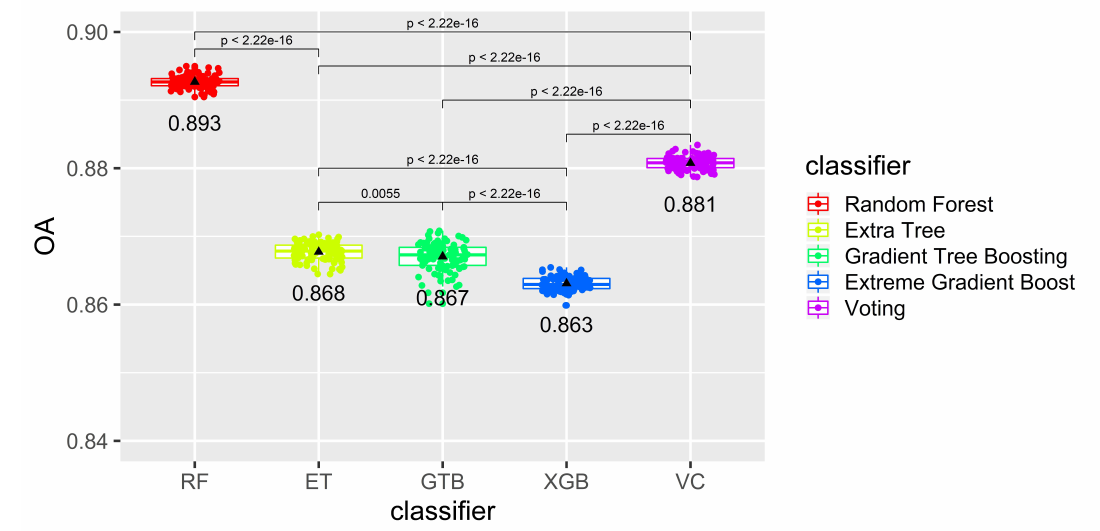
Figure 9. Overall accuracy (OA) comparison obtained from the di ff erent Ensemble classifiers. p -values resulting from the t-test comparisons are displayed. Black triangles represent the mean OA values (also